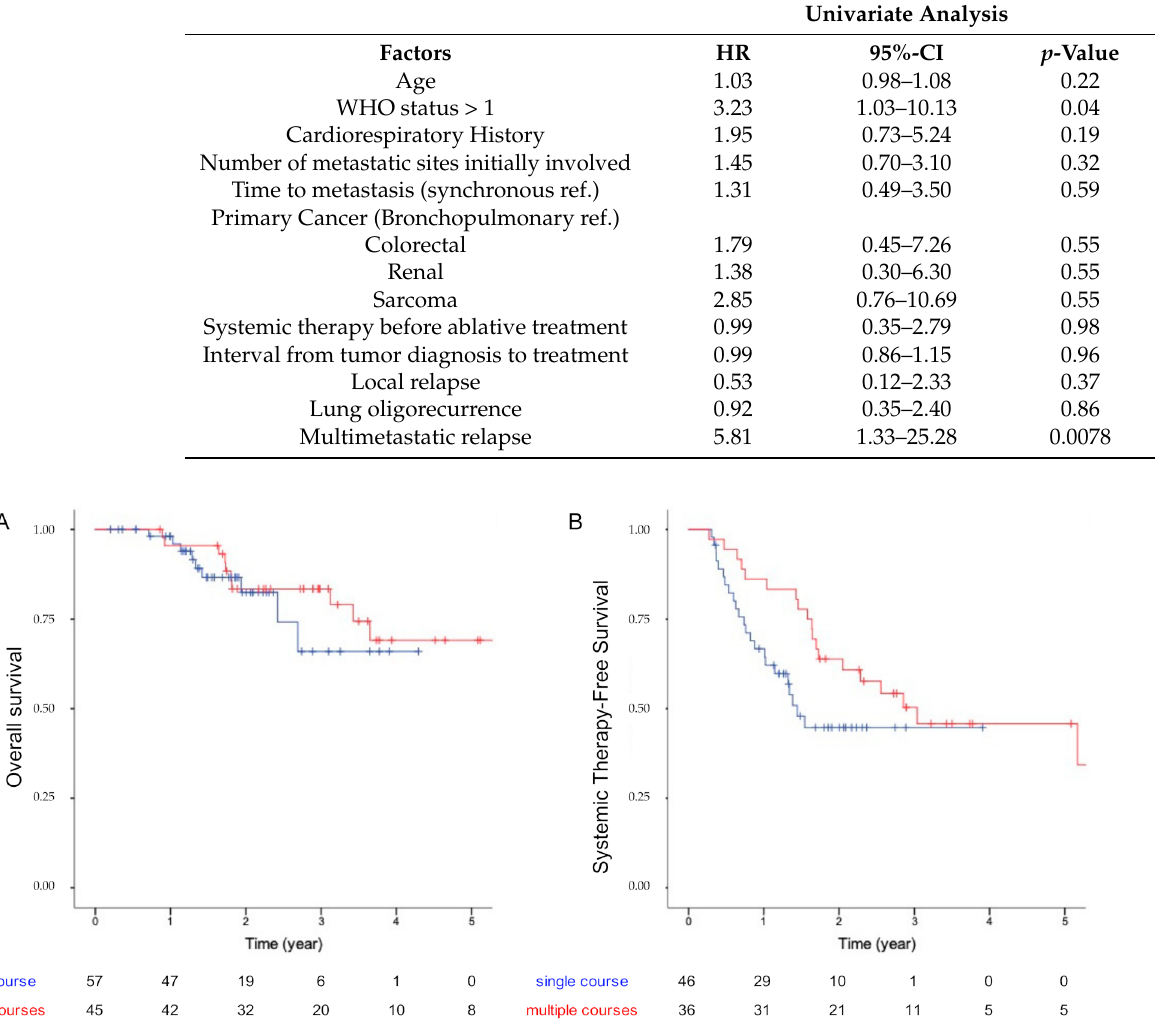
Figure 2. Kaplan–Meier curves showing the overall survival ( A ) and systemic therapy free sur- vival ( B ) of the “single course” group (in blue) and “multiple courses” group (in red) treated with ablative